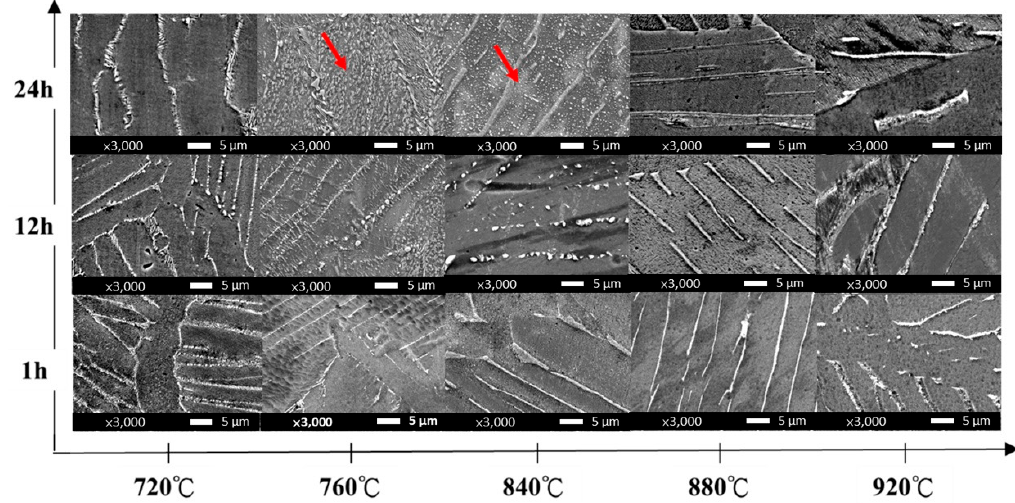
Figure 2. SEM electron micrographs of the specimens annealed at 720–920 °C for 1, 12, and 24 h (the red arrows indicate fine Ti 2 Cu precipitates).